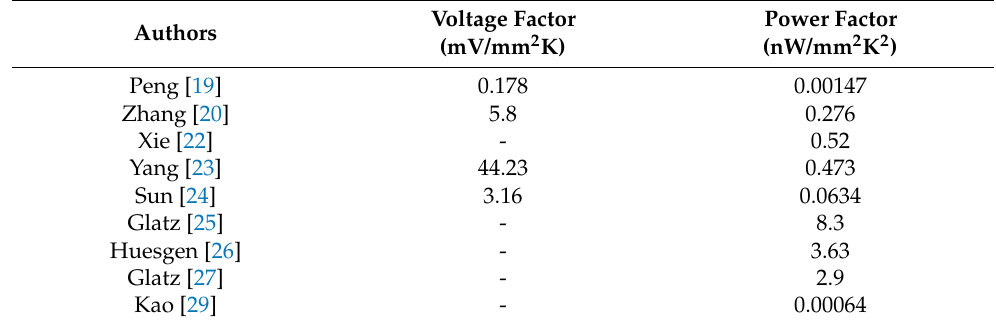
Table 1. Performances of